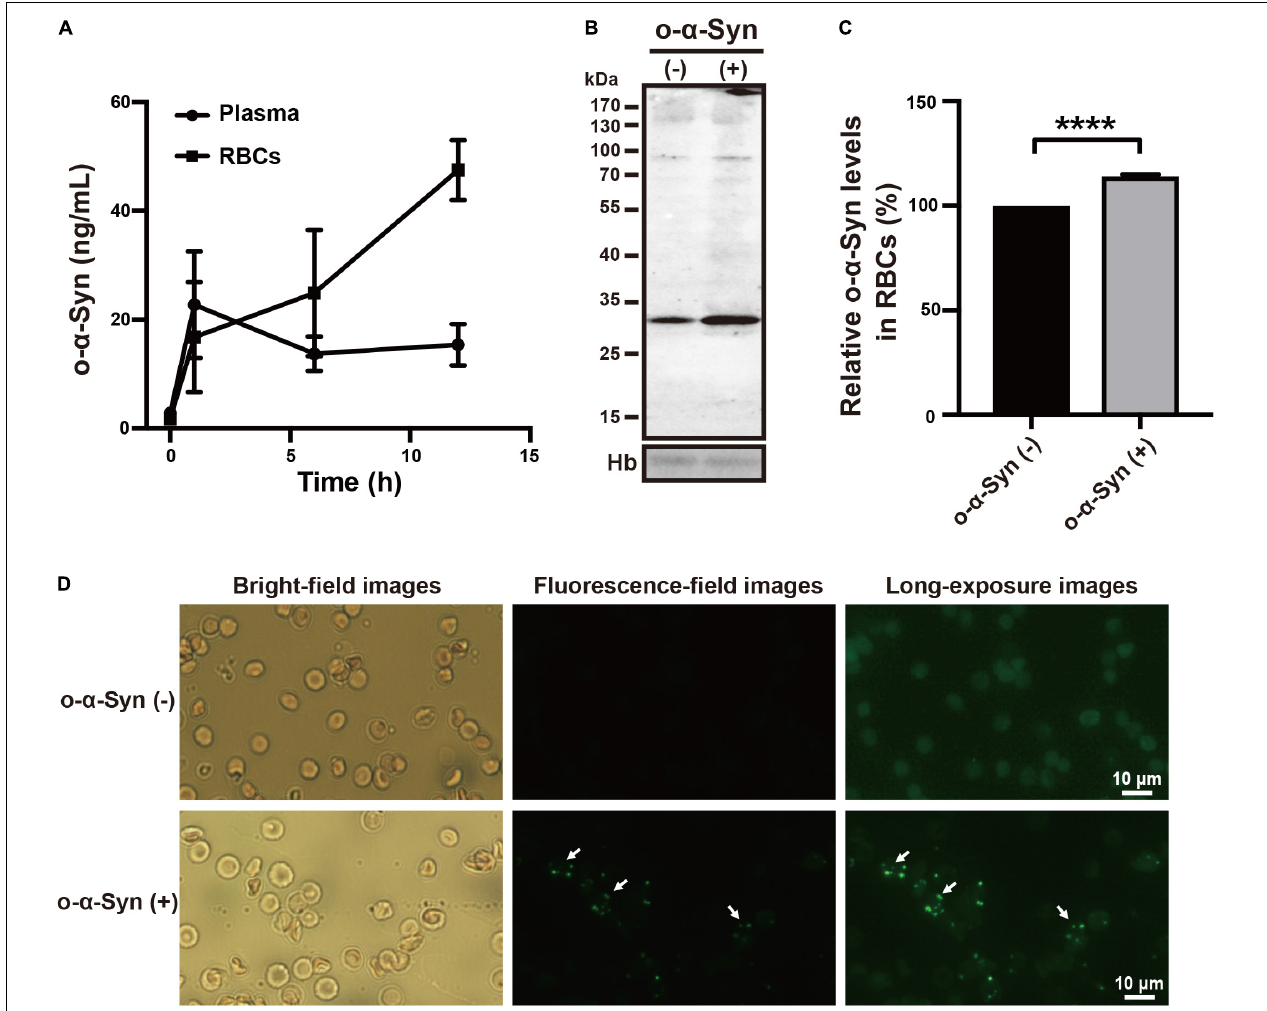
FIGURE 2 | Plasma o- α -Syn transport into RBCs in mice. (A) RBC o- α -Syn levels in o- α -Syn-injected mice increased significantly in a time-dependent manner, contrasting with the slight change in plasma o- α -Syn levels. (B,C) RBCs of o- α -Syn-injected mice had more o- α -Syn than those of control mice did. (D) RBCs of o- α -Syn-treated mice had granular α -Syn-immunoreactive fluorescent particles (scale bar = 10 µ m). n = 3; **** p < 0.0001. Hb, hemoglobin.